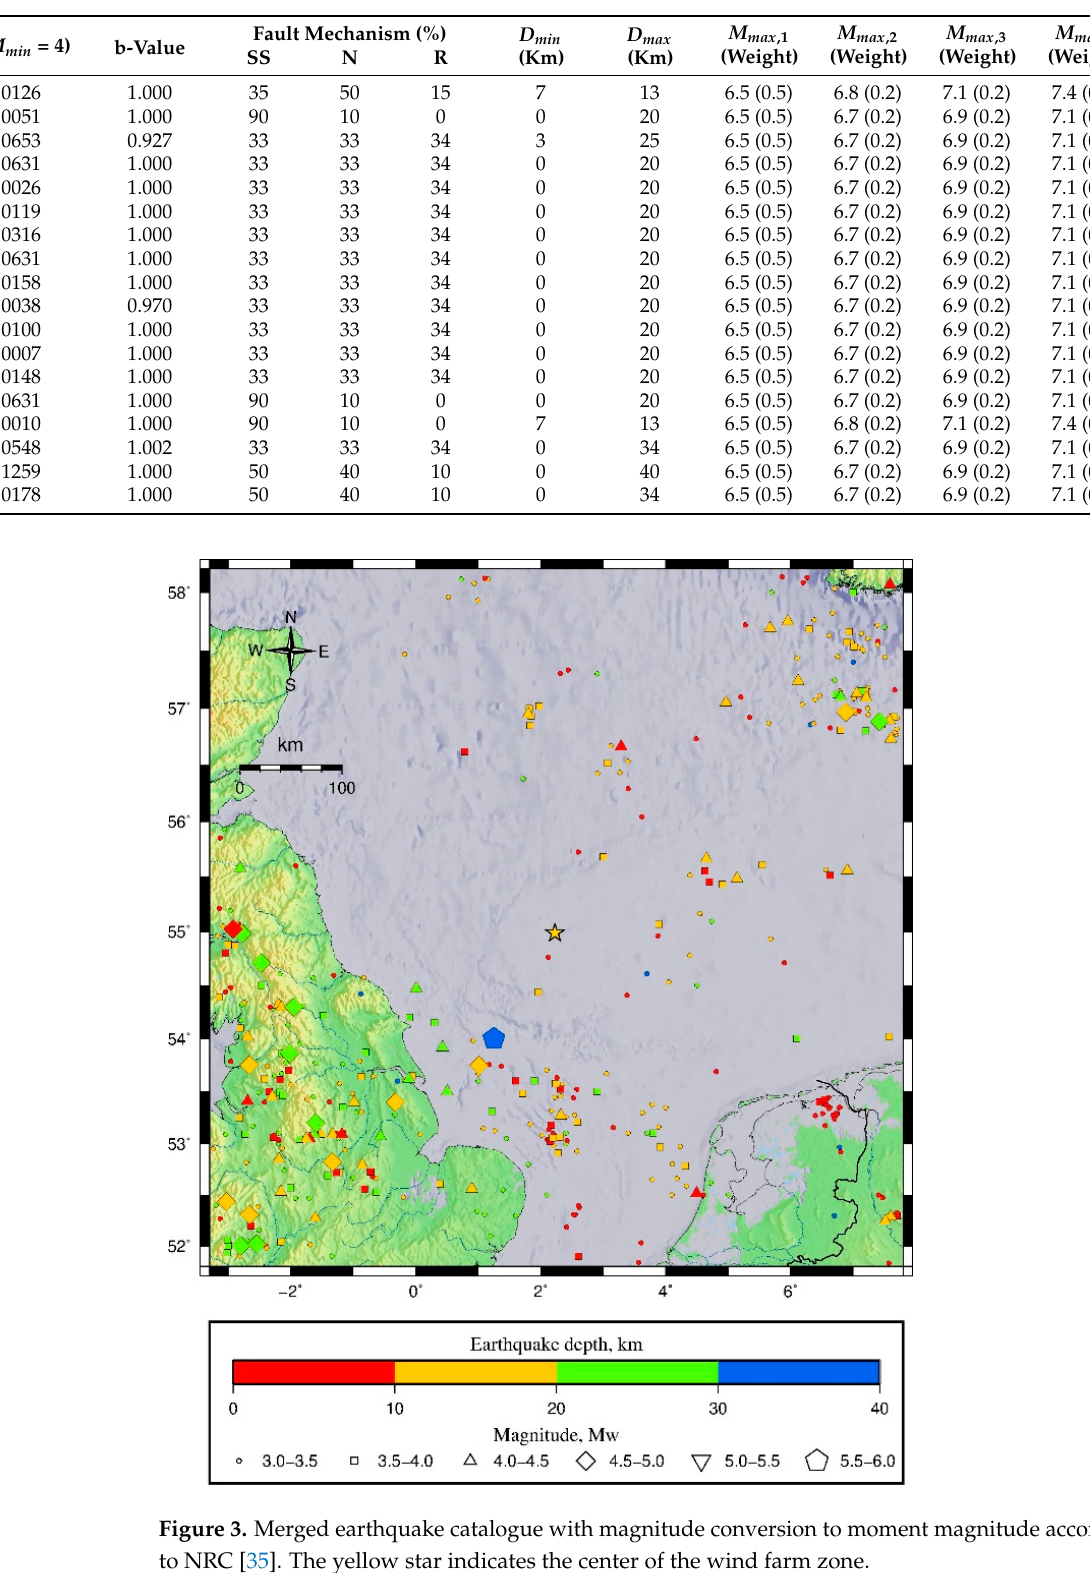
Table 3. Source characteristics for SSM2.